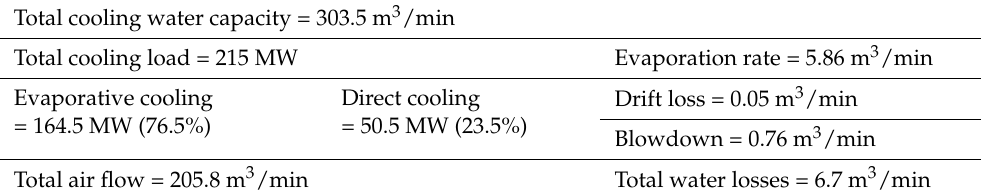
Table 2. Design parameters after refurbishing the cooling tower.